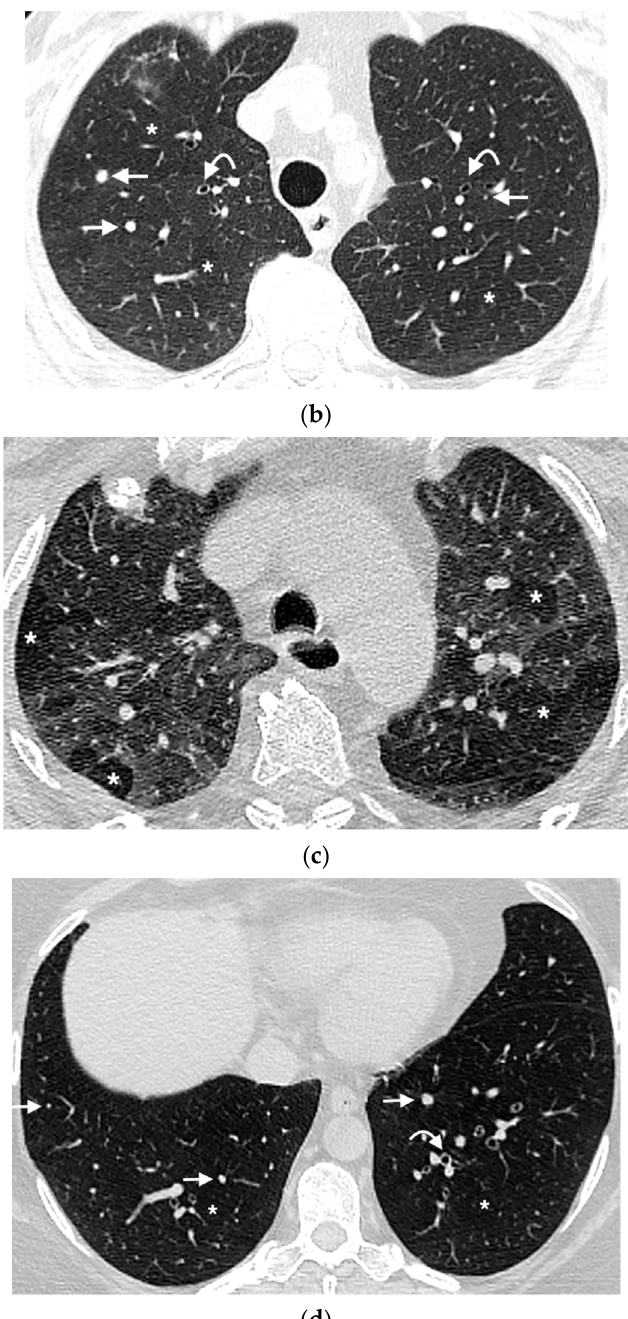
Figure 1. DIPNECH CT case examples. ( a ) Axial CT thorax in a middle aged woman with DIPNECH, status post right lung resection demonstrates multiple scattered small pulmonary nodules (arrows), bronchial wall thickening (curved arrow) and multifocal lobular and regional mosaic attenuation (*). ( b ) Axial CT thorax in an older woman with DIPNECH shows mild bronchial wall thickening (curved arrows), occasional scattered small pulmonary nodules (arrows) and mild lobular mosaic attenuation (*). ( c ) Expiratory CT image in the same patient demonstrates lobular and regional areas of air trapping (*). ( d ) Axial CT of the lung bases in a middle aged woman with DIPNECH showing bibasal pulmonary nodules (arrows), borderline dilated mildly thick-walled airways (curved arrow) and lobular mosaic attenuation (*).